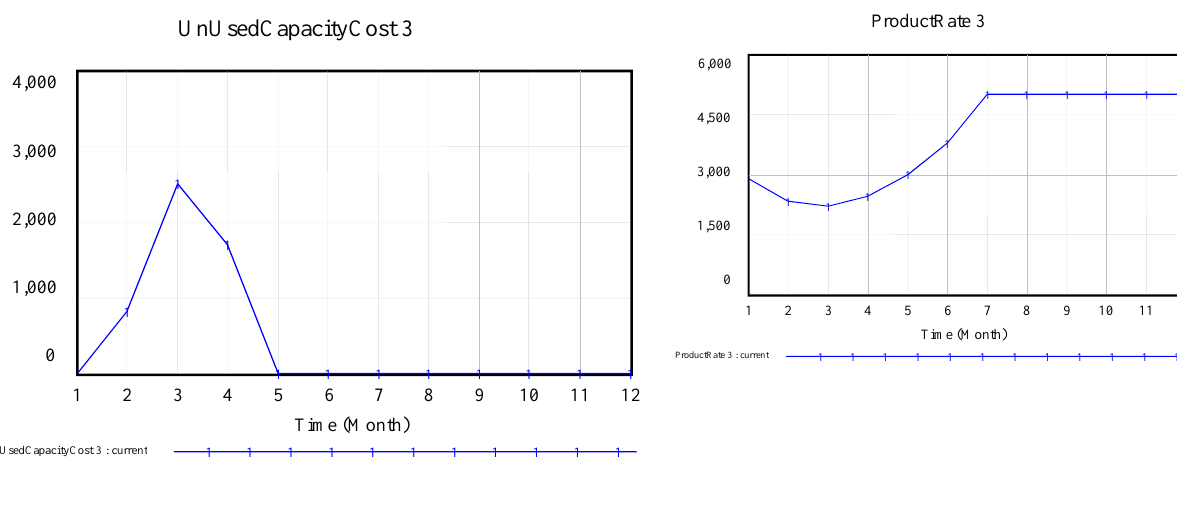
Fig. 5. The unused capacity expenses and production